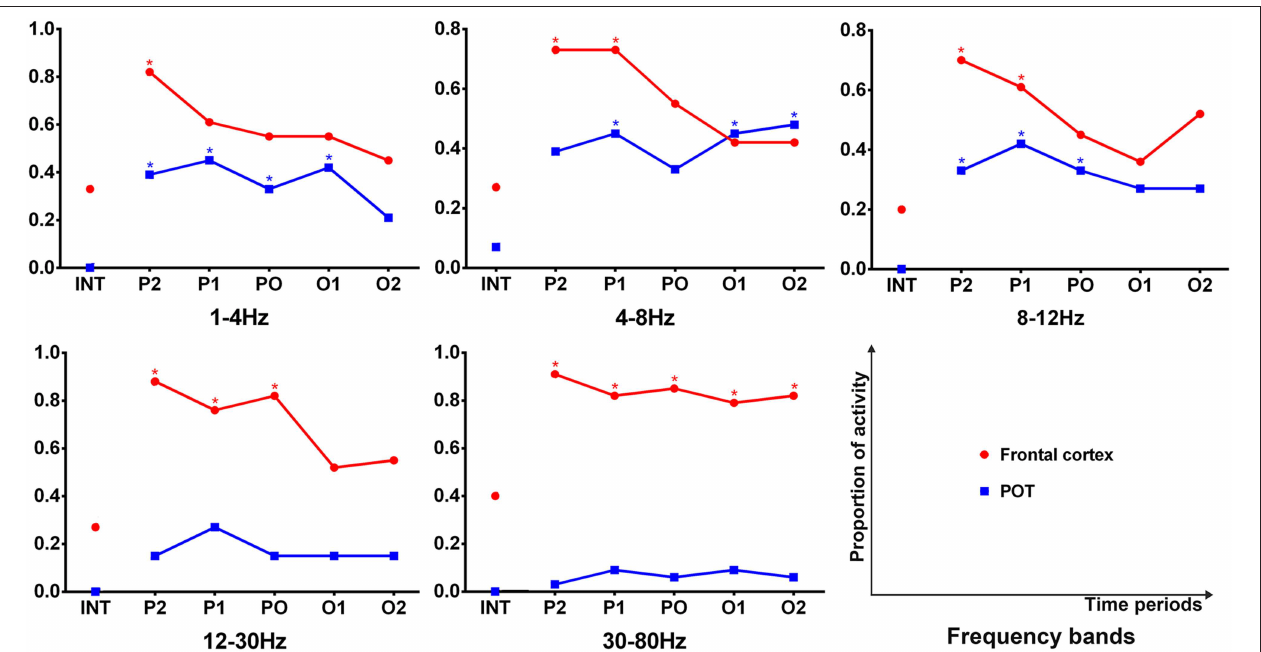
FIGURE 3 | Comparison in sources of the frontal cortex and parieto–occipito–temporal junction (POT) between the interictal and offset transition periods for five lower frequency bandwidths. The y-axis indicates the proportion of data segments where the corresponding area was activated. Six time epochs are listed on the x-axis. Fisher’s exact test was performed for comparisons between the termination transition (P2, P1, PO, O1, and O2) and interictal (INT) periods. Asterisks: p < 0.05 after FDR (corrected for 5 × 5 × 2 tests) with red for the frontal cortex and blue for the